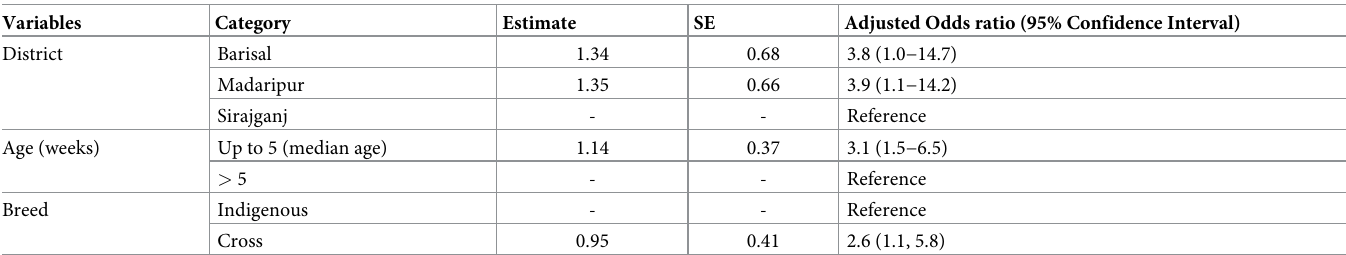
Table 4. Risk factors identified in the final multivariable logistic regression analysis for rotavirus infection in diarrheic calves in Bangladesh.